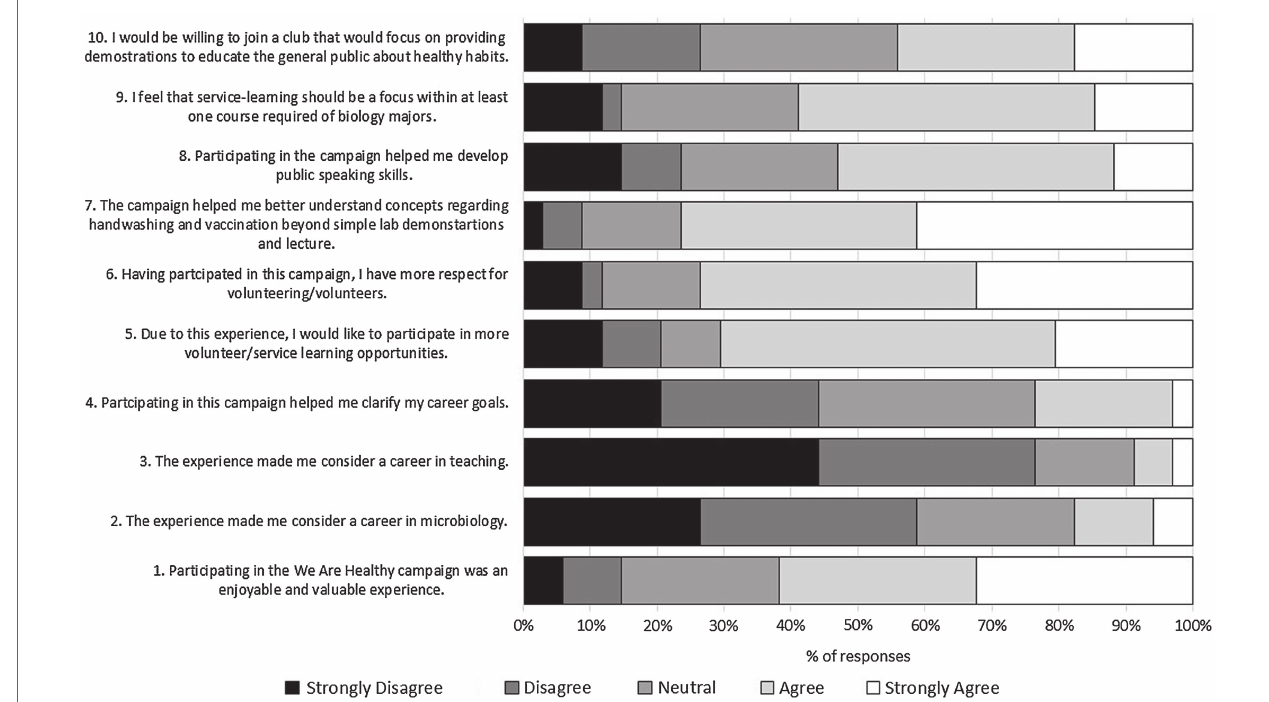
FIGURE 1 | Assessment questions and responses from microbiology students ( n = 34) after participation in the “We Are Healthy”